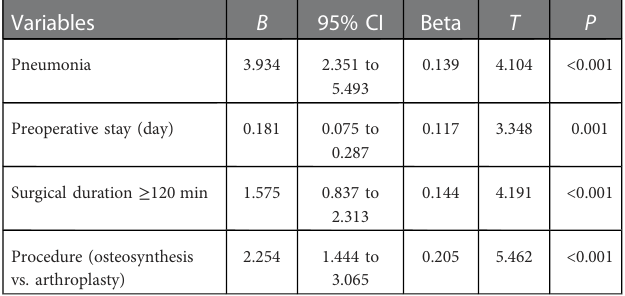
TABLE 4 ^ Multivariate linear regression analysis showing pneumonia signi fi cantly positively associated with postoperative hospitalization stay, together with other 3 factors.